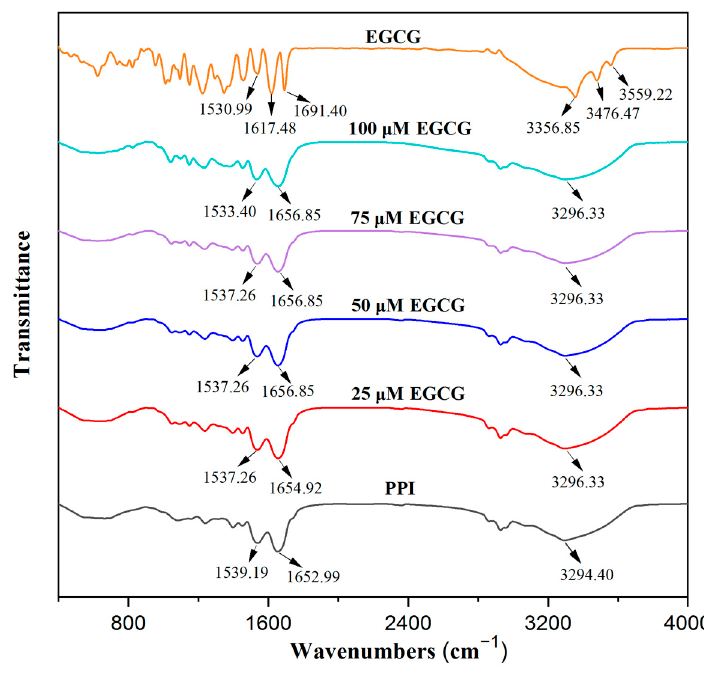
Figure 4. FTIR spectra of EGCG and PPI with different EGCG concentrations.